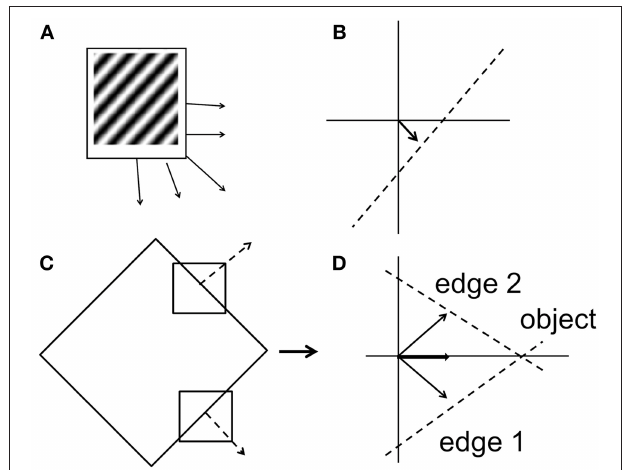
FIGURE 3 | Aperture Problem. (A) A grating pattern consisting of alternating black and white bars. The grating is allowed to move in different directions. Thin arrows in (A) represent the set of physical motions of the grating pattern in various directions. The motion of all these grating patterns is indifferent when viewed through a small window, and this motion direction is perpendicular to the orientation of the grating (as a thick arrow shown in B ). This ambiguity in determining the direction of motion of the grating is termed as aperture problem. In case of motion of a two-dimensional object (e.g., square or diamond), local motion cues (dotted arrows show in C ) are divergent and are very different from the actual object motion. In (D) thin arrows represent the local motion of each edge seen through RF. An intersection of two constraint lines from both the edges represents the true motion of an object (thick arrow in D ).